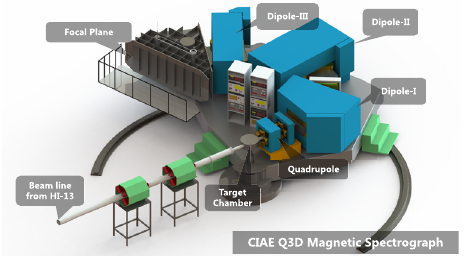
Figure 1. Typical experimental setup for high-energy transfer measurement performed using the Q3D magnetic spectrograph at HI-13 tandem accelerator of CIAE. The Q3D magnetic spectrograph consists of a target chamber, a quadrupole, three dipoles, and detector arrays at the focal